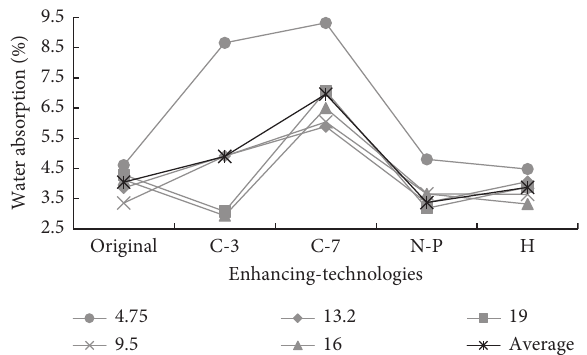
Figure 5: Average value of water absorption value of RA before and after chemical enhancing-technology.